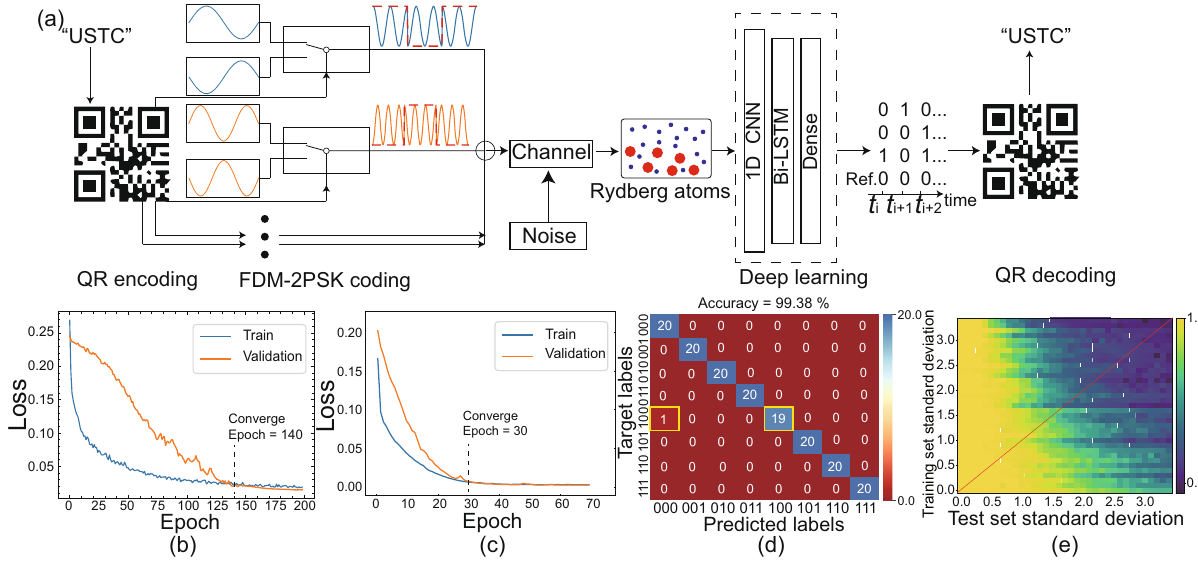
Fig. 2 Flow chat of recognizing the multifrequency MWs and results. a Process of encoding and decoding frequency-division multiplexed binary phase- shift keying (FDM-2PSK) signal with Rydberg atoms and the deep learning model. b , c Loss curve evolution with epochs for the training set (blue) and the validation set (orange) during training with different training data and validation data. The training data sizes are b 393 and c 1194. The validation data sizes are b 131 and c 398; more details about the data set split are presented in the “ Methods ” section. The loss curves for training and validation converge at b 140 and c 30 epochs, where an epoch is a time unit during which the model iterates once over the complete data set; see “ Methods ” section. d Confusion matrix for a test set (the number of the testing set is 160 and the labels are uniformly distributed) after training in case ( c ). The accuracy reaches 99.38% after a 70-epoch training period. e Deep learning model accuracy on the noisy test set after training on the noisy training set. The x - and y -axes represent the standard deviations of the additional white noise added to the test set and the training set, respectively. The colorbar represents the accuracy of the model on the noisy test set. The results were obtained by averaging fi ve sets of predictions. The diagonal (red line) indicates the accuracy of the model on a test set in which the noise distribution is the same as that of the training set; more details about the noise are shown in Supplementary